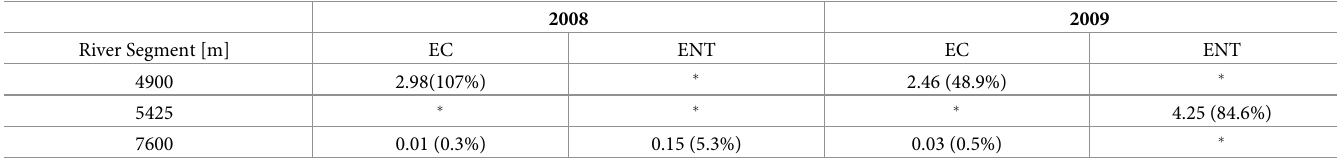
Table 6. Required flow rates from input ditches to the Hanalei River to achieve river loadings of FIB observed in the field. Units of the reported values are m 3 /s. The corresponding percentage of the Hanalei River flow are shown in